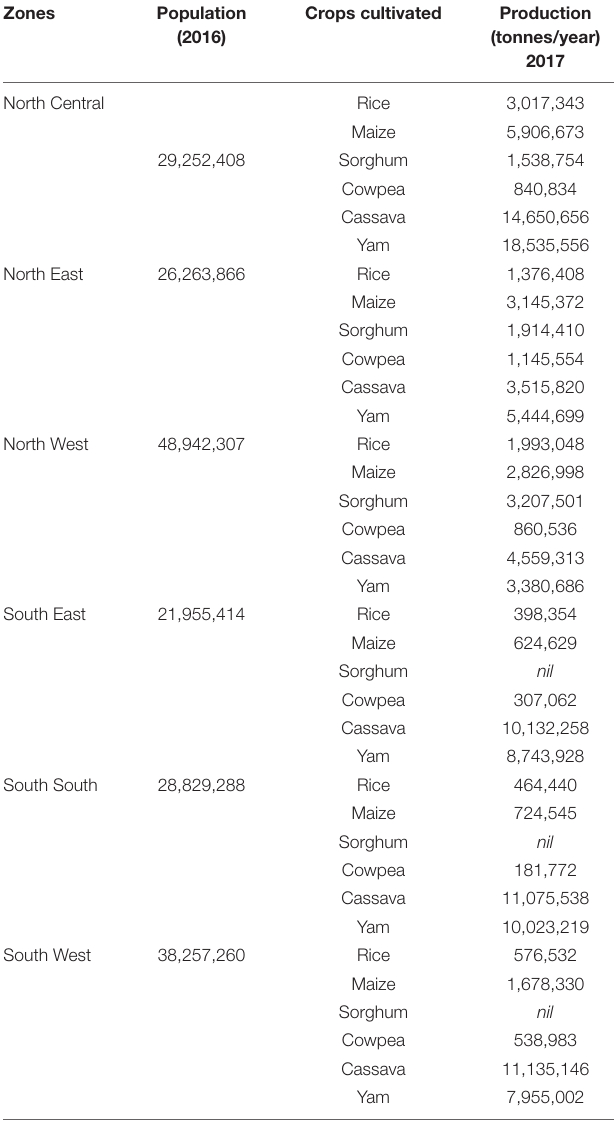
TABLE 2 | 36 states grouped in six geopolitical zones outlook on population, and local production in 2017